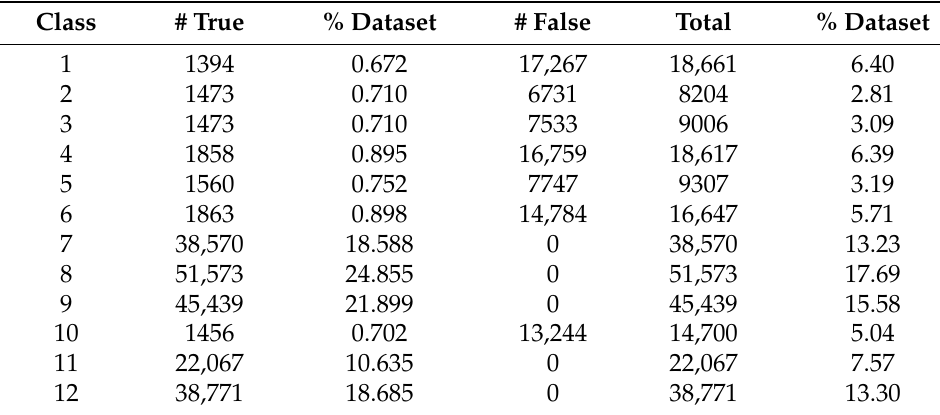
Table 3. Distribution of the dataset by class.